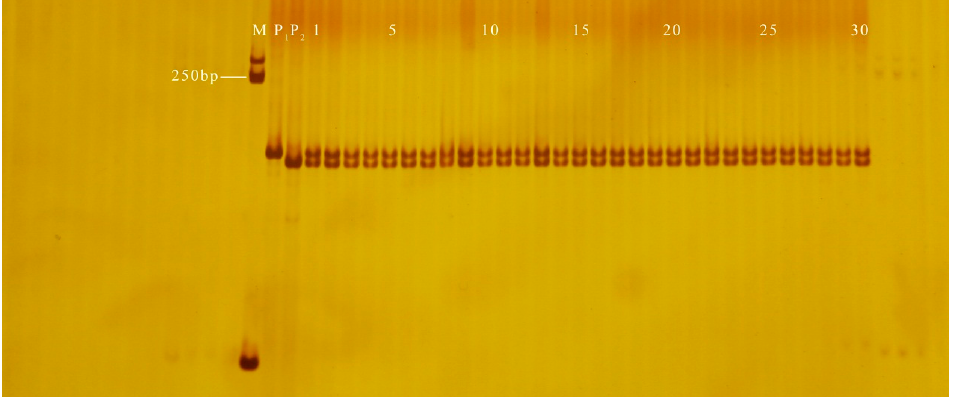
Figure 9. Purity identification of some plants of ‘Lvxianzi 2’ wax gourd by GX1. M: DL2000 DNA Marker; P 1 : GK-3-4-3-2-1-3 (nearly spherical); P 2 : 7-2-1-3-2-2-1 (cylindrical); 1–30: ‘Lvxianzi 2’ wax gourd.